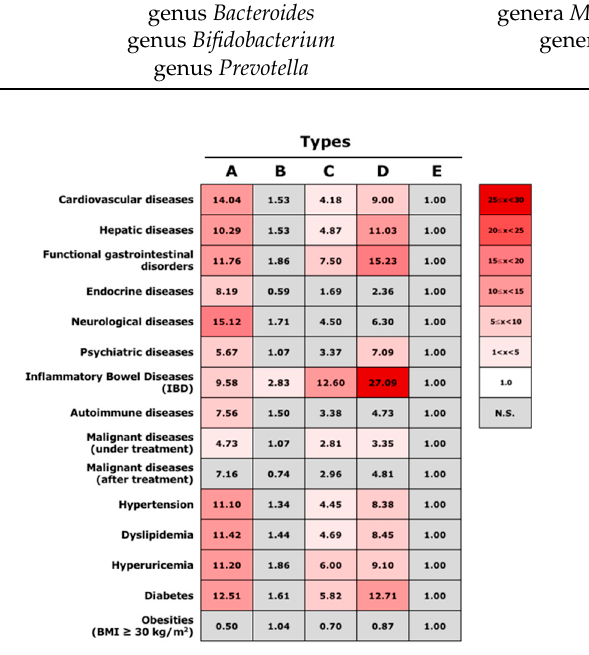
Figure 4. Odds ratios of various diseases in each of the PAM-identified types. The odds ratio for various diseases in each PAM-identified type was calculated based on the number of individuals with each disease. Statistically significant differences ( p < 0.05) were calculated based on the Wald test. Red boxes indicate significantly higher odds ratios of diseases in comparison to type D. Gray boxes indicate no significant difference with type D.